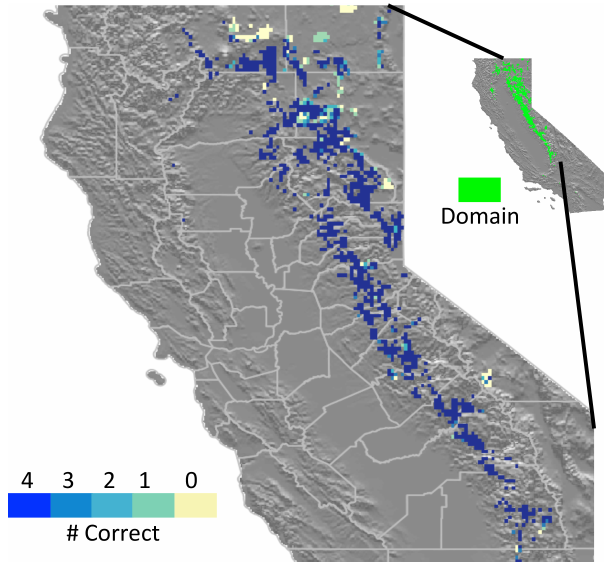
Figure 5. Number of simulations with correct pine fraction, ac- cording to the LEMMA (Ohmann et al., 2011) dataset, out of four FATES simulations with plausible pine and incense cedar parame-